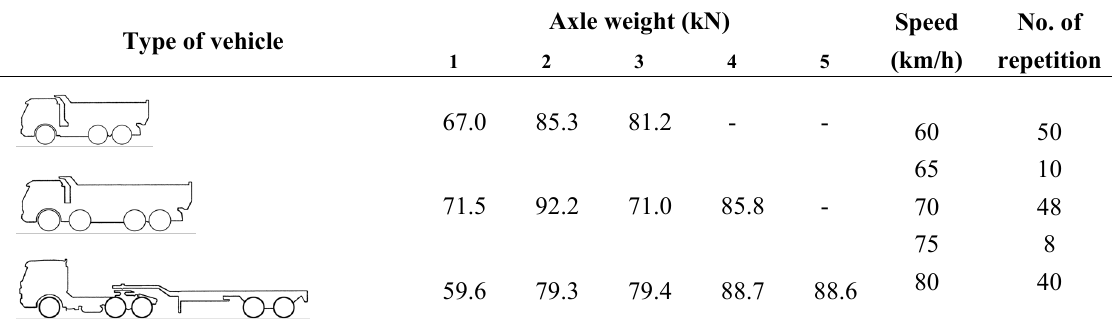
Table 2. Weight of test trucks and test cases of Seohae Bridge.